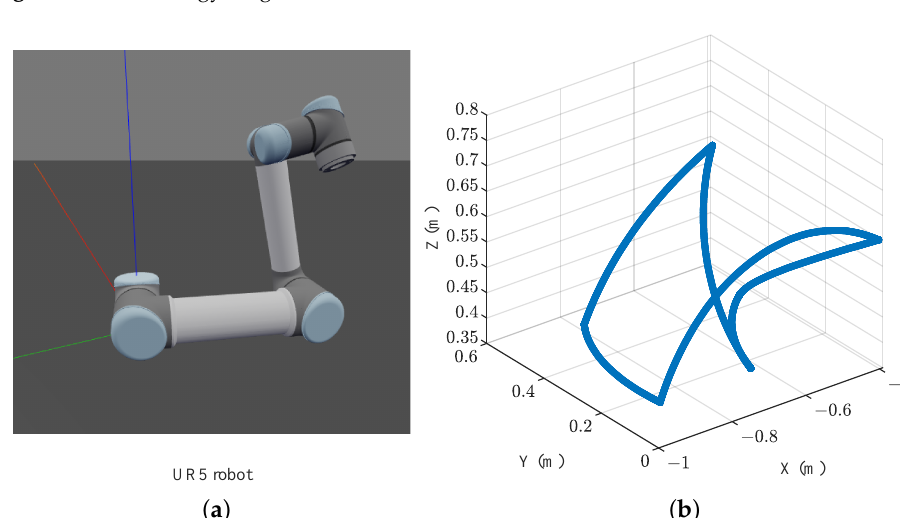
Figure 4. Methodology diagram.